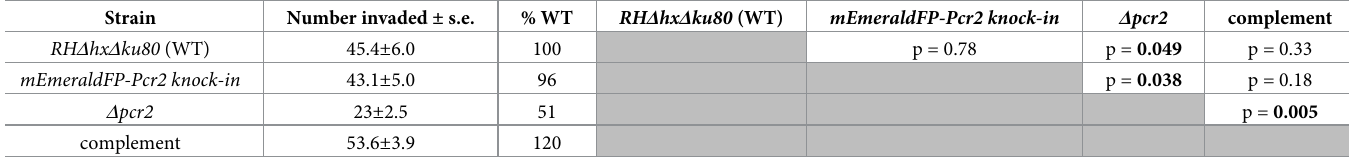
Table 2. Quantification of invasion for the four T . gondii strains. The number of intracellular parasites per field was counted in ten fields per strain, in each of three independent biological replicates. s.e.: Standard error of the mean. P-values from unpaired Student’s t-tests are indicated on the right. Strain Number invaded ± s.e. %